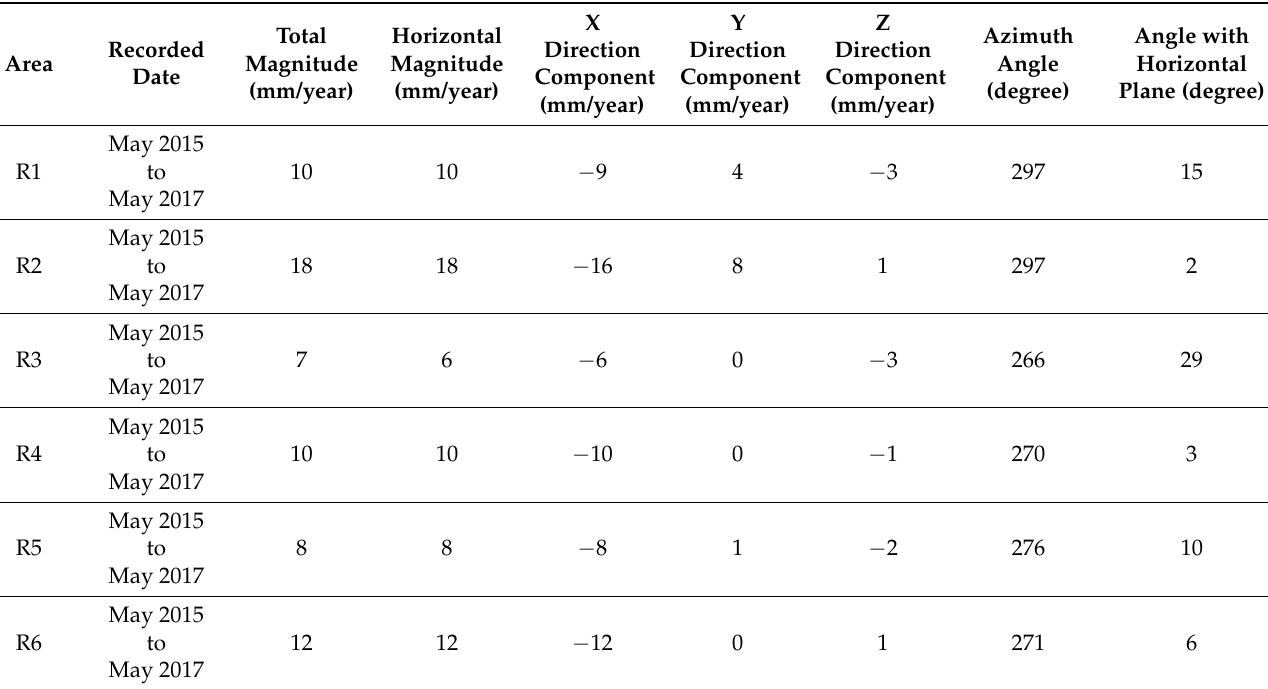
Figure 23. Calculated vertical component of R for selected sectors at the Barnard landslide. Table 7 summarizes the components of calculated R and the geometry of these vectors. Table 7. Summary of calculated R components magnitude and vector geometry at the Barnard landslide.